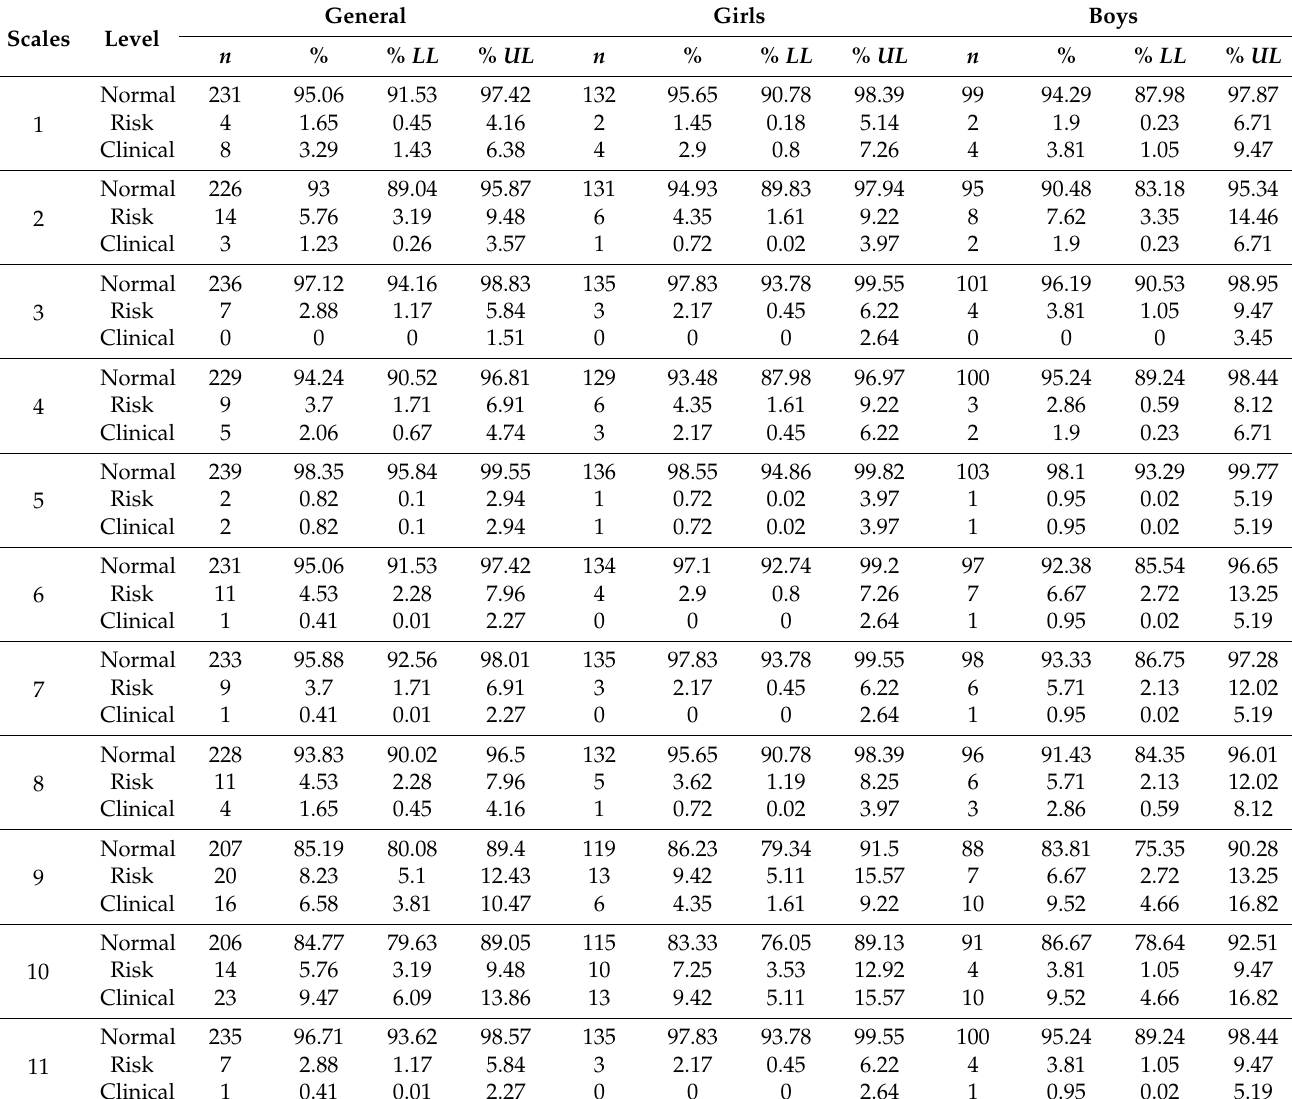
Table 8. Prevalence of syndromes according to the